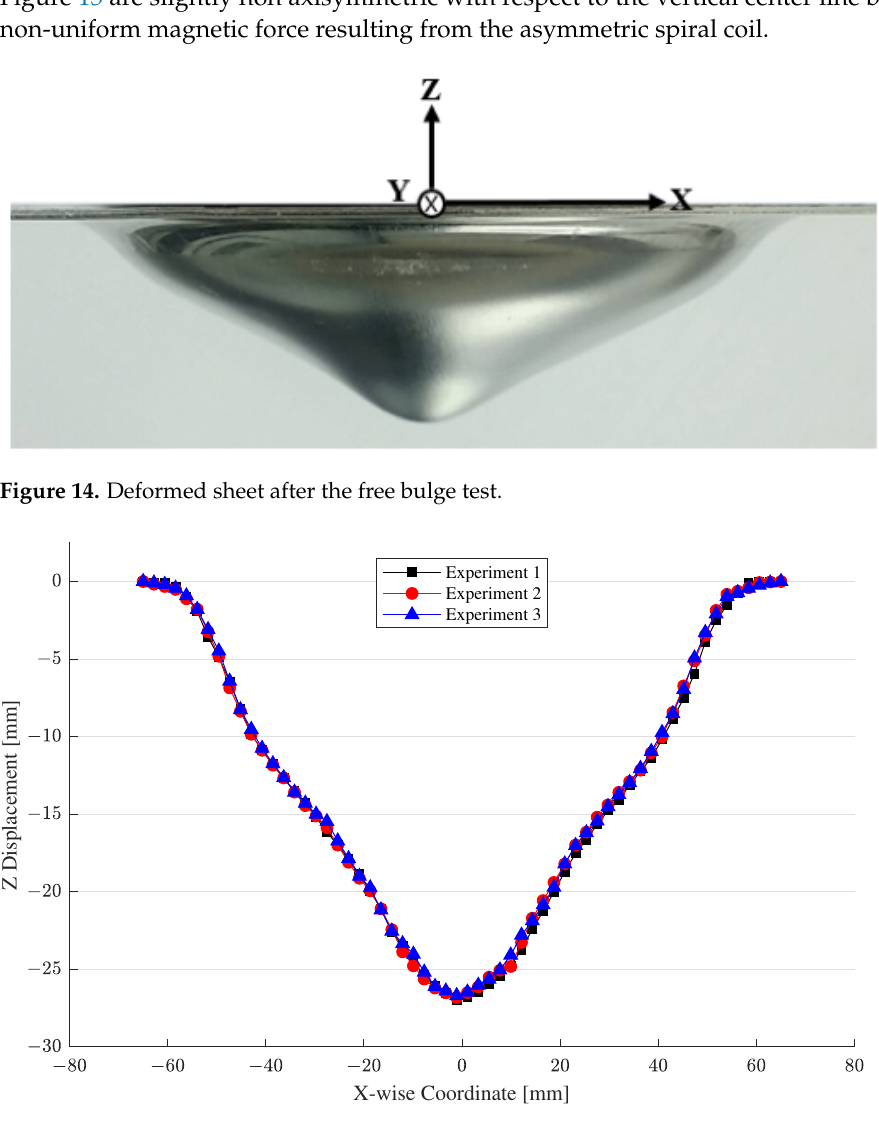
Figure 15. Measurements of the deformed